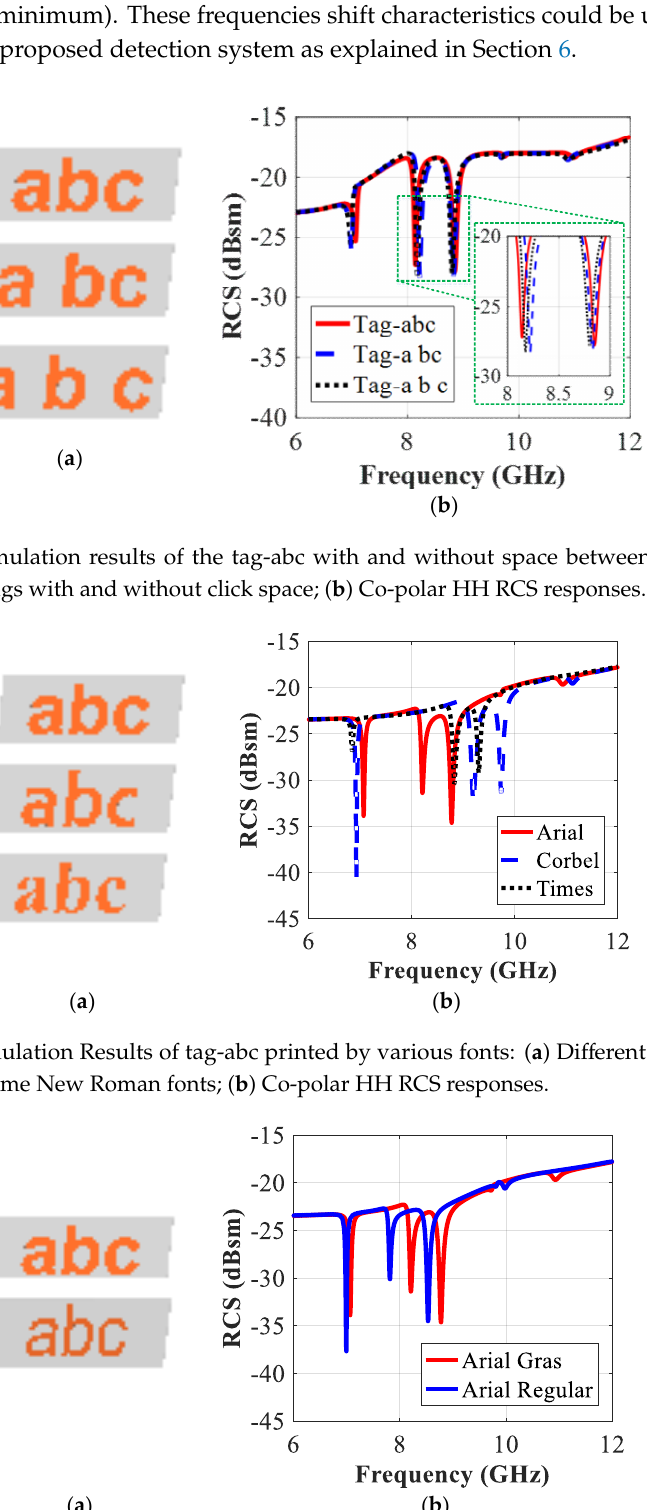
Figure 18. RCS Simulation results of tag-abc printed by Arial font with different styles: ( a ) Tag-abc